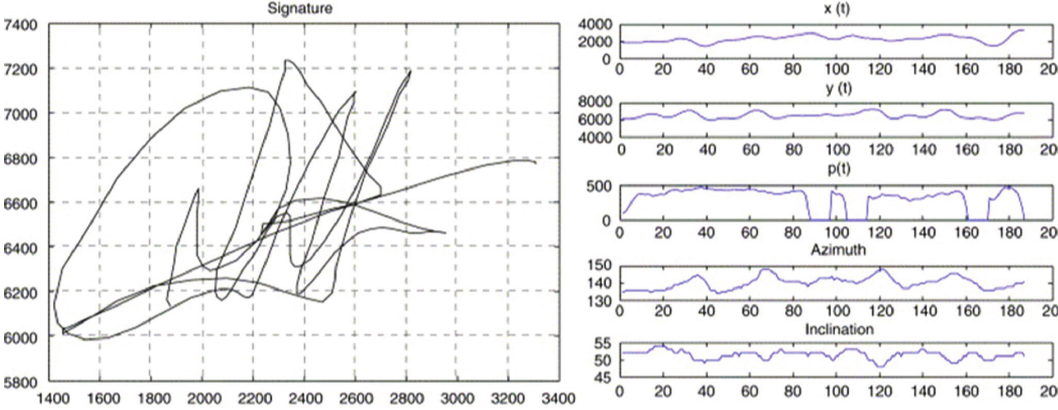
Figure 5 Example of signature with static and dynamic features (taken from